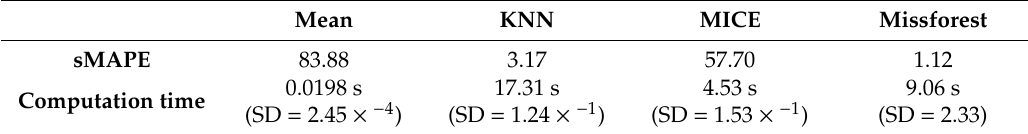
Table 4. Total average sMAPE and computation time of imputation